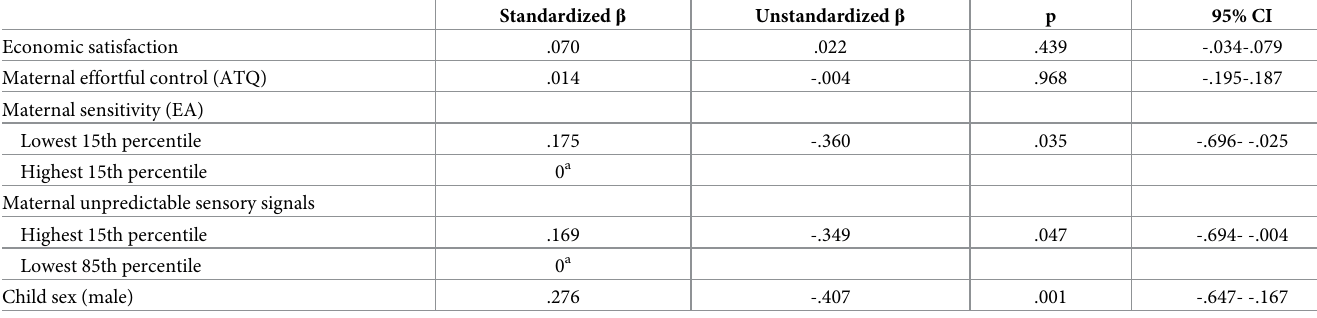
Table 5. The general linear model for child effortful control (using categorical